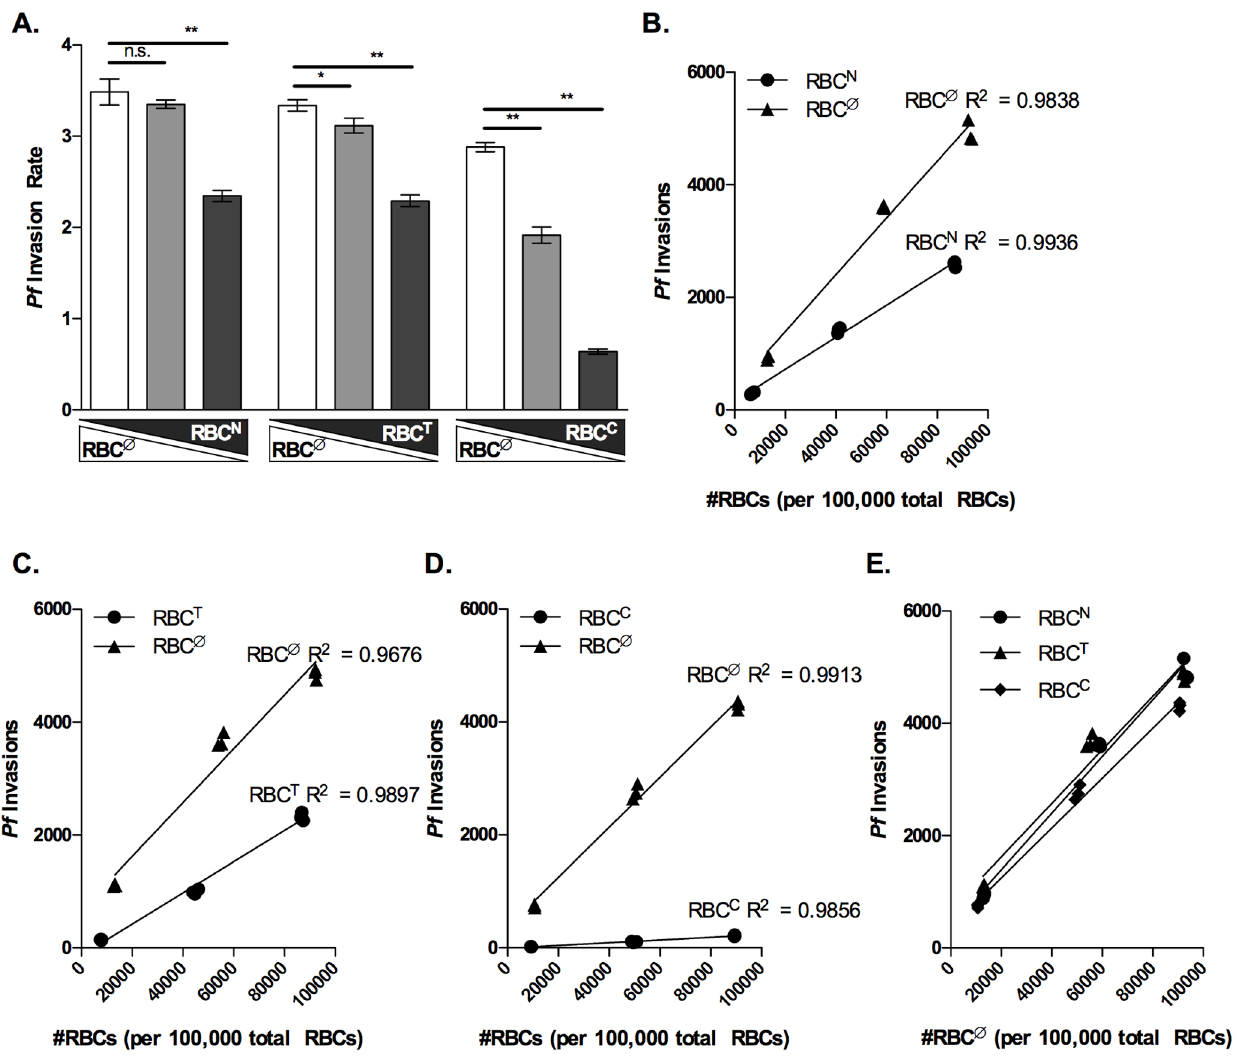
Figure 4. Invasion of P.falciparum strain 3D7 decreases as untreated RBCs are replaced with enzyme treated RBCs. RBCs were labeled with either CellTrace DDAO or Violet before enzyme treatment (neuraminidase, trypsin, or chymotrypsin). 1.8 6 10 7 , 1 6 10 7 , and 2 6 10 6 non- enzymatically treated RBCs (RBC Ø ) were combined with 2 6 10 6 , 1 6 10 7 , and 1.8 6 10 7 of enzyme treated RBCs (RBC N , RBC T , or RBC C ) respectively to achieve 10:1, 1:1, and 1:10 combinations of RBC Ø to either RBC N , RBC T , or RBC C in the barcoded RBC invasion assay. Invasion assays were inoculated with 2 6 10 5 of MACS purified trophozoite stage P. falciparum strain 3D7 parasites and invasion assays were performed as previously described. Data is from a single representative experiment of three independent experiments performed in triplicate. (A) Rate of 3D7 invasion into 1:10, 1:1, and 10:1 combinations of RBC Ø and either RBC N , RBC T , or RBC C . Bars represent the mean invasion rate and error bars represent the SD. Elongated triangles below the X-axis represent the replacement of RBC Ø (white triangle) with either RBC N , RBC T , or RBC C (gray triangle) in the total RBC population. Student’s t -tests were used to compare invasion rates, *p , 0.02 and **p , 0.0002. (B, C, and D) Data shows the number of invasion events into RBC Ø (triangles) and either RBC N , RBC T , or RBC C (circles) as the frequency of each RBC type increases from 10% to 90% of the total RBC population. Linear regression was used to determine the best fit line for P. falciparum invasion of RBC Ø , RBC N , RBC T , and RBC C . ANCOVA was performed to compare the slopes of the lines fit to P. falciparum invasion of RBC Ø , RBC N , RBC T , and RBC C . The null hypothesis was no difference between RBC Ø and either RBC N , RBC T , or RBC C (H 0 : b Ø = b enzyme , a =0.05). ANCOVA performed with GraphPad, Prism, v. 5.04, La Jolla, CA calculated a p , 0.0001. (E) RBC Ø datum from panels B–D were superimposed to compare invasion into RBC Ø when RBC Ø was combined with RBC N (circles) RBC T (triangles) or RBC C (diamonds). Linear regression was used to determine the best fit line for RBC Ø invasion data. ANCOVA was performed to compare the slopes of the lines fit to P. falciparum invasion of RBC Ø . The null hypothesis was that there would be no difference in the invasion of RBC Ø in the presence of the other RBC populations (H 0 : b Ø = b enzyme , a =0.05). ANCOVA performed with GraphPad, Prism, v. 5.04, La Jolla, CA calculated a p , 0.2599. expected, P. falciparum invasion of RBC Ø and enzyme treated RBCs as a function of RBC number is significantly different ( Figure 4B–D and 5B–D ). Finally, we show that P. falciparum invasion of untreated RBCs is not competitive as it is not affected by the presence of enzyme treated RBCs ( Figure 4E and 5E ).